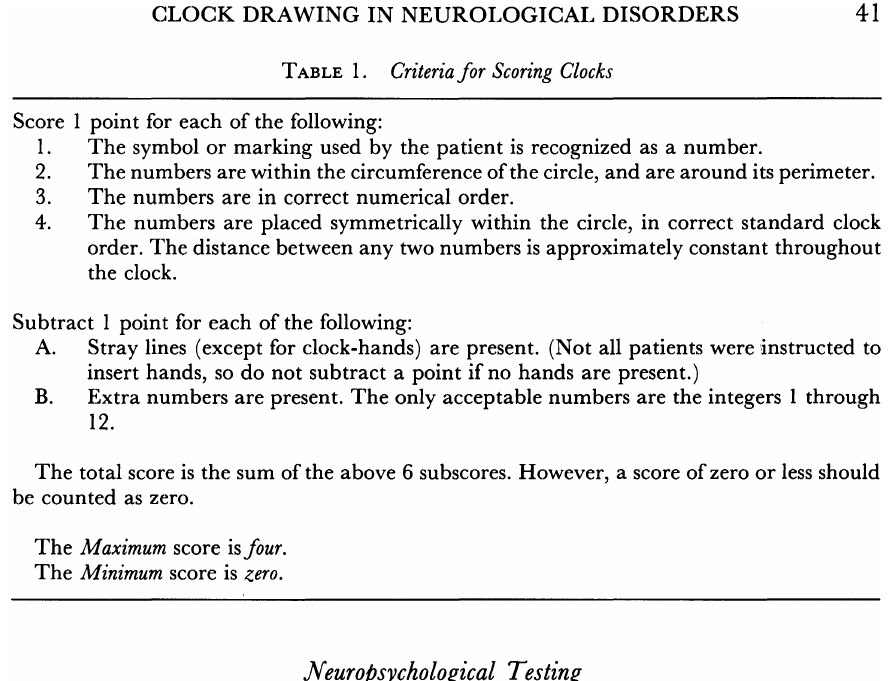
TABLE I. Criteria for Scoring